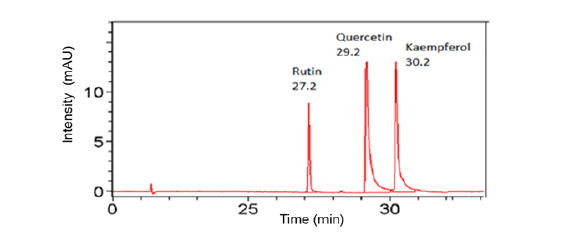
Figure 4. HPLC-UV chromatogram of flavonol standards rutin, quercetin, and kaempferol (10 ppm) with the respective retention times detected at 360